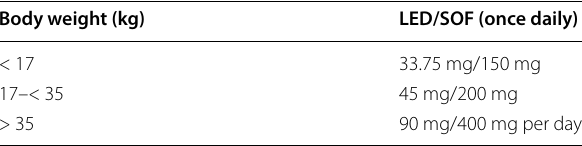
Table 1 Weight-based dosing of LED/SOF for children aged